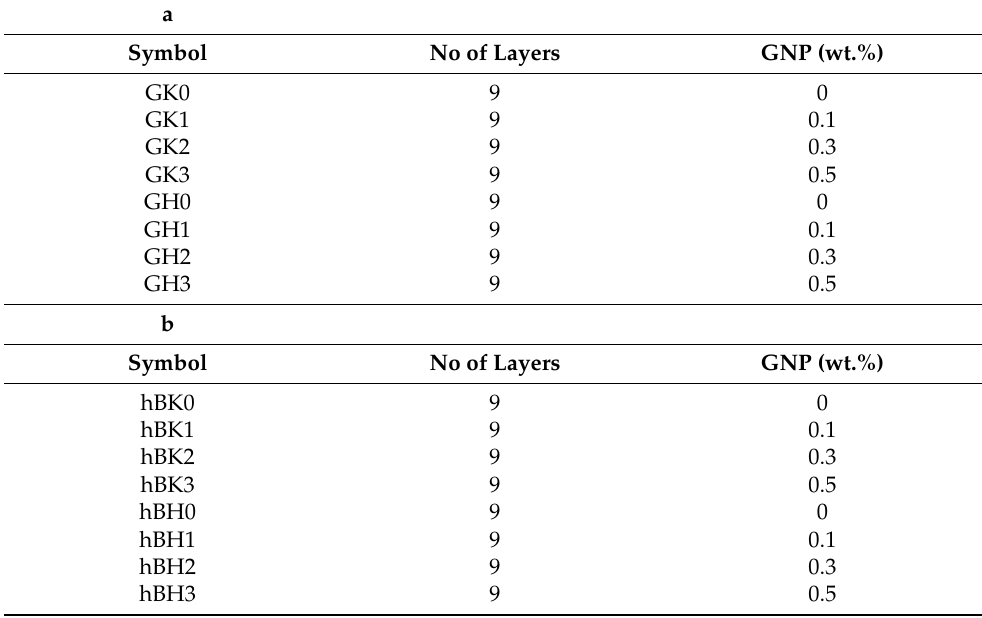
Table 1. ( a ). Specification material according to GNP wt.%. ( b ) Specification of material according to h-BN